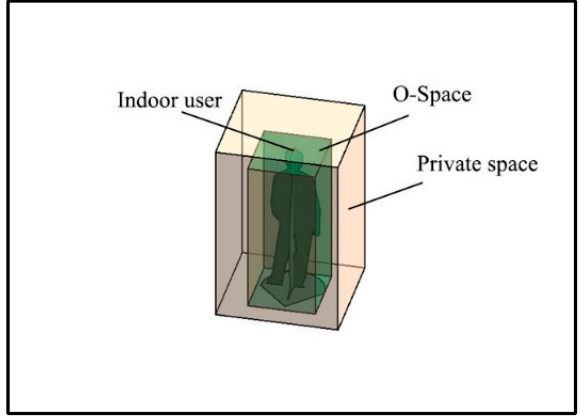
Figure 3. The O-Space and the private space of a user.